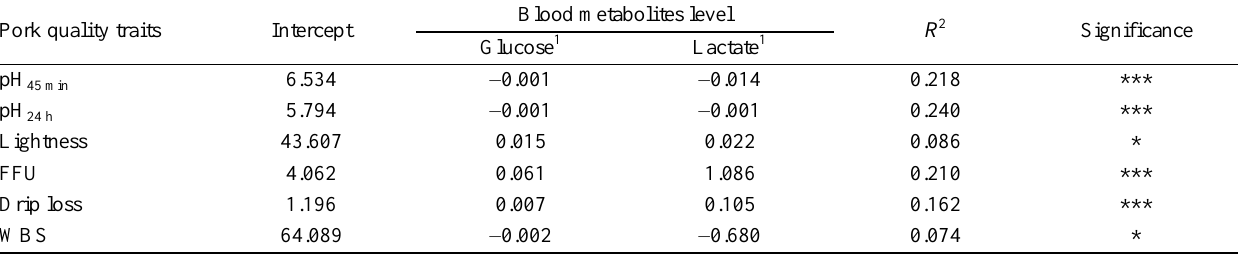
Table 3. Multiple regression models for certain pork quality traits using blood glucose and lactate levels measured at exsanguination Pork quality traits